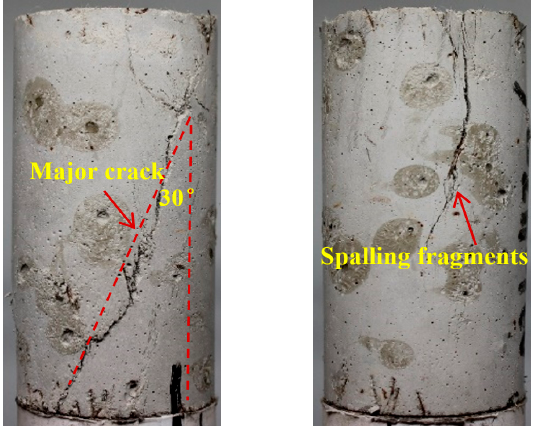
Figure 13. Crack pattern of Hy2 mixture after triaxial compression.